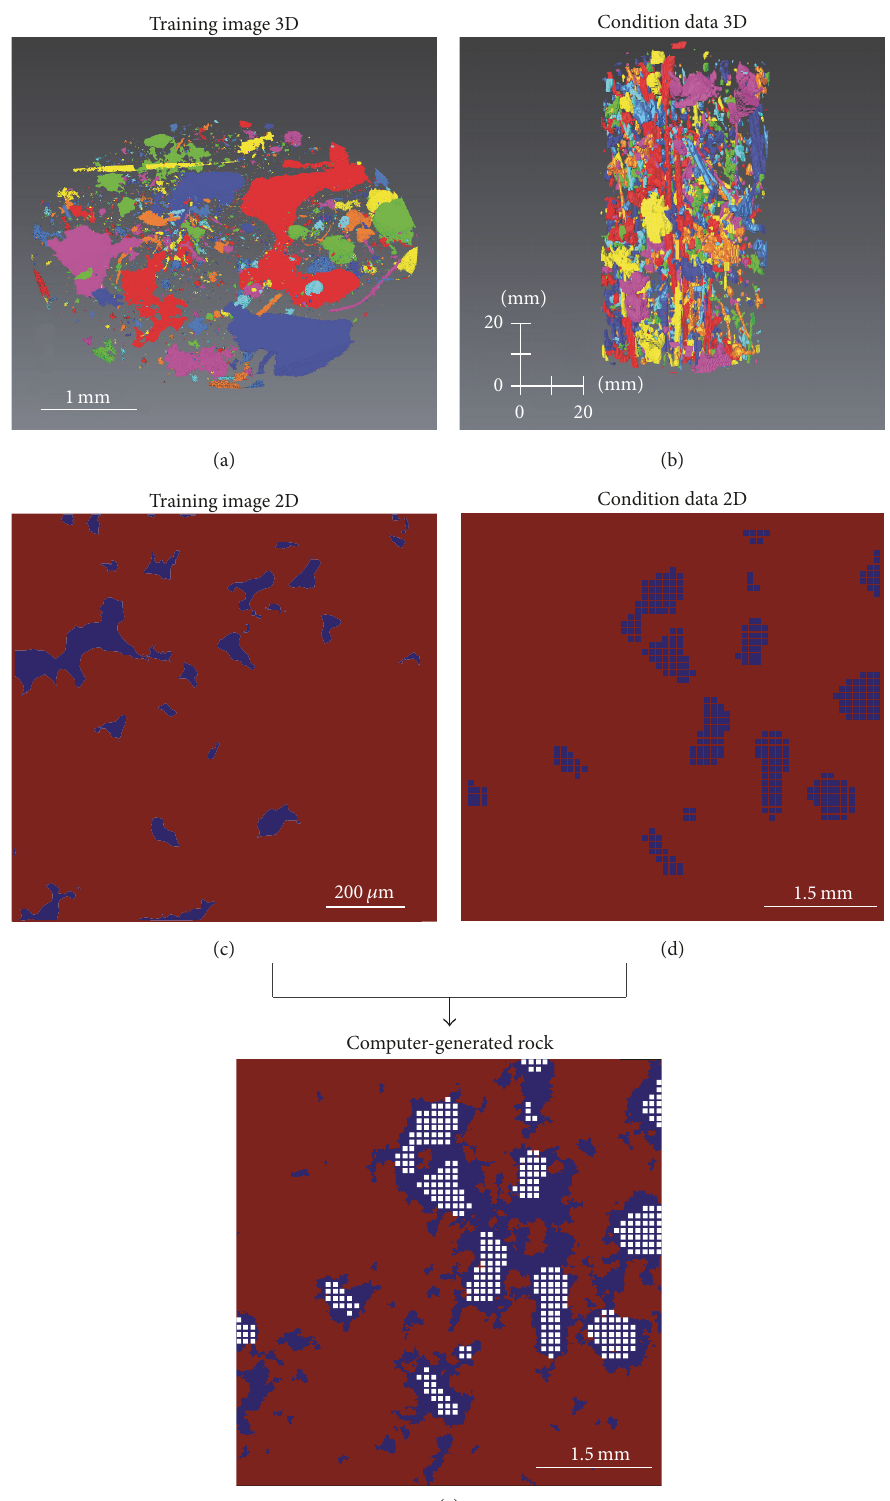
Figure 4: Schematic outline of the MPS upscaling workflow. (a) 3D training image at high resolution and (b) 3D conditioning data at low resolution. Colors indicate pore connectivity. (c) 2D slice through the TI shown in (a) and (d) through the conditioning data shown in (b). Pores are given in blue. (e) Computer-generated rock slice, with the conditioning data (white) plotted on top of the generated porosity